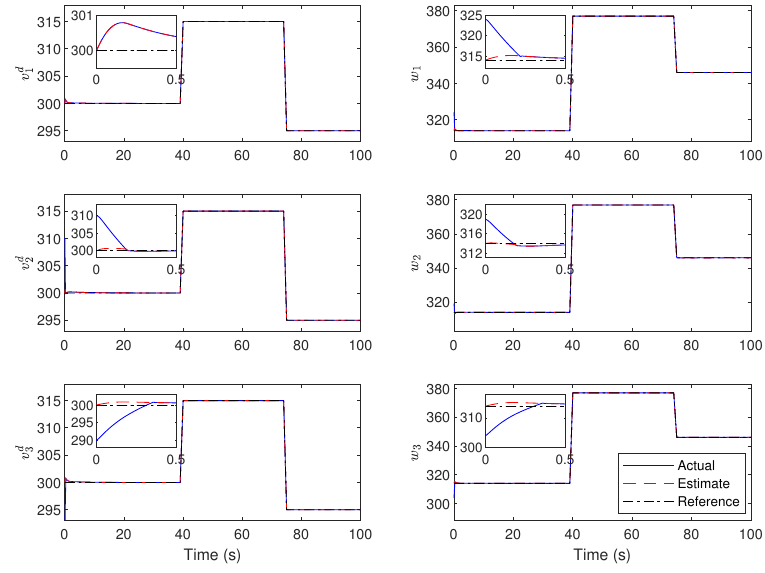
Figure 13. The states of system (53) (solid), their estimates from the distributed SMOs (dashed), and the reference value (dash-dotted) for the case where u d , i for i = 1,2,3 is implemented as designed in